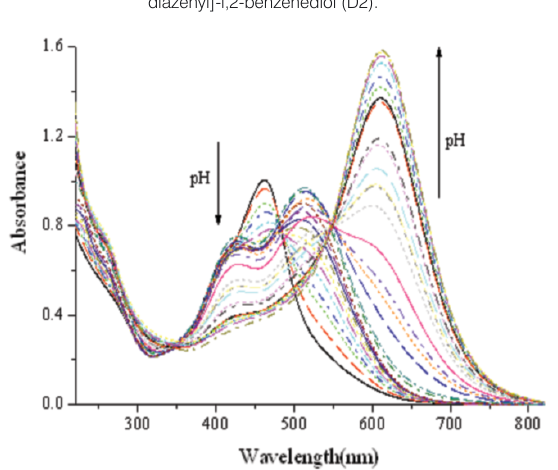
Figure 3. Titration spectra of 5.0×10 -5 mol L -1 4-[(2,4-dinitrophenyl) diazenyl]-l,2-benzenediol (D3).